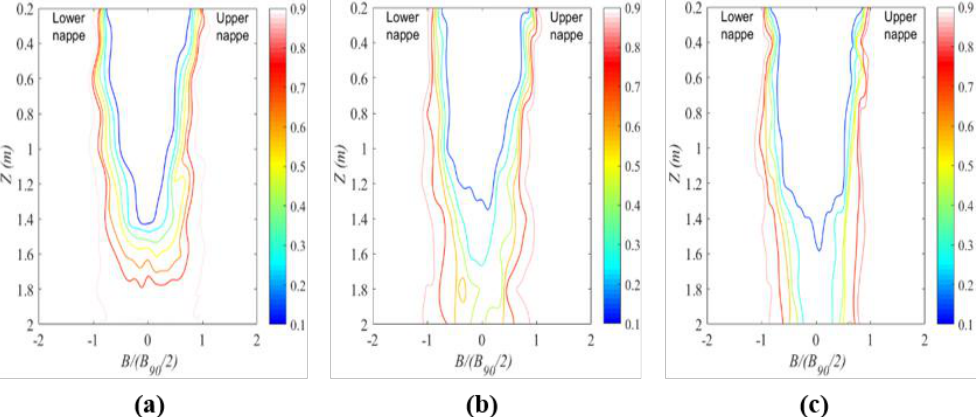
Figure 5. Contour map of void fraction distributions C as a function of the dimensionless thickness B /( B 90 /2): ( a ) q = 0.024 m 3 /s/m; ( b ) q = 0.048 m 3 /s/m; ( c ) q = 0.096 m 3 /s/m.